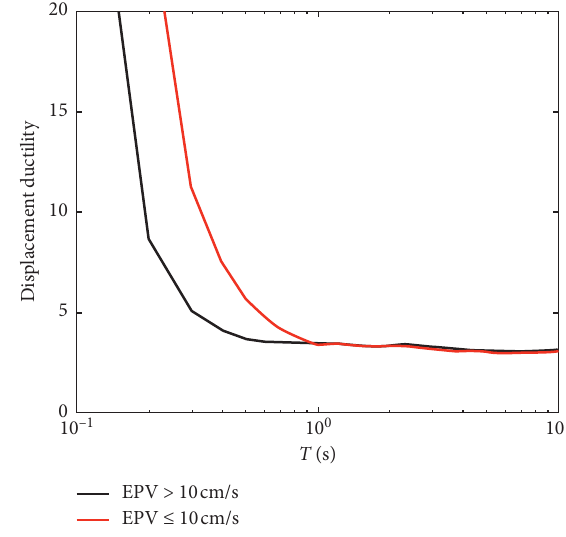
Figure 13: Effect of EPV on the variation of mean constant- strength ductility